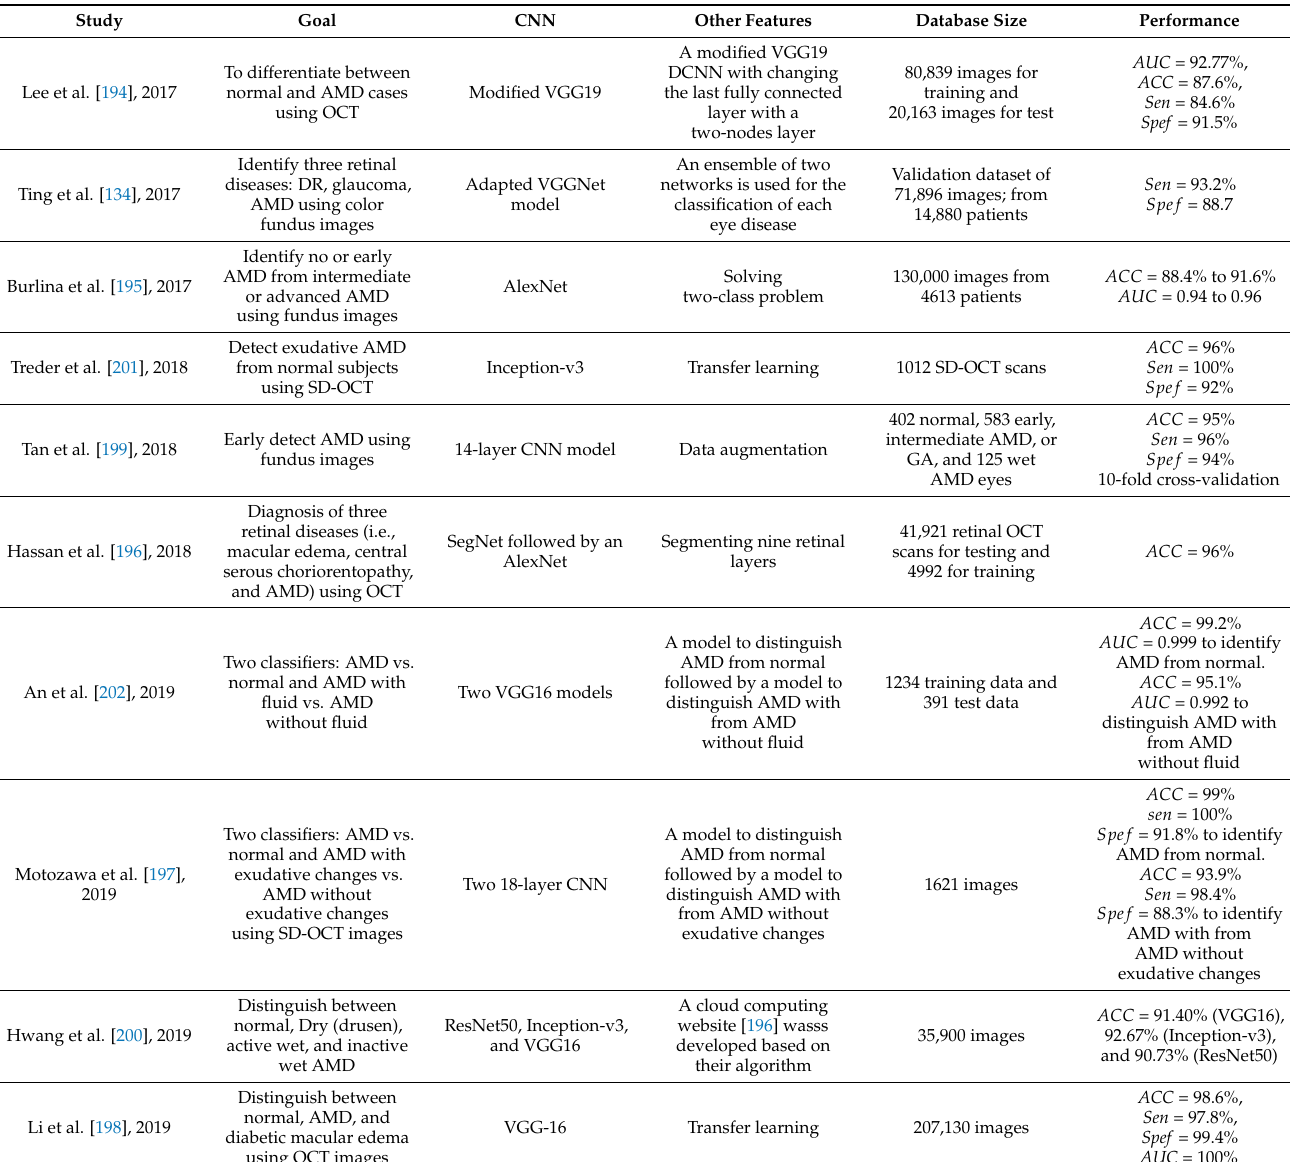
Figure 8. Summary of deep learning methods for AMD detection, diagnosis, and/or staging. Table 4. Deep learning methods for early detection, diagnosis, and grading of AMD.